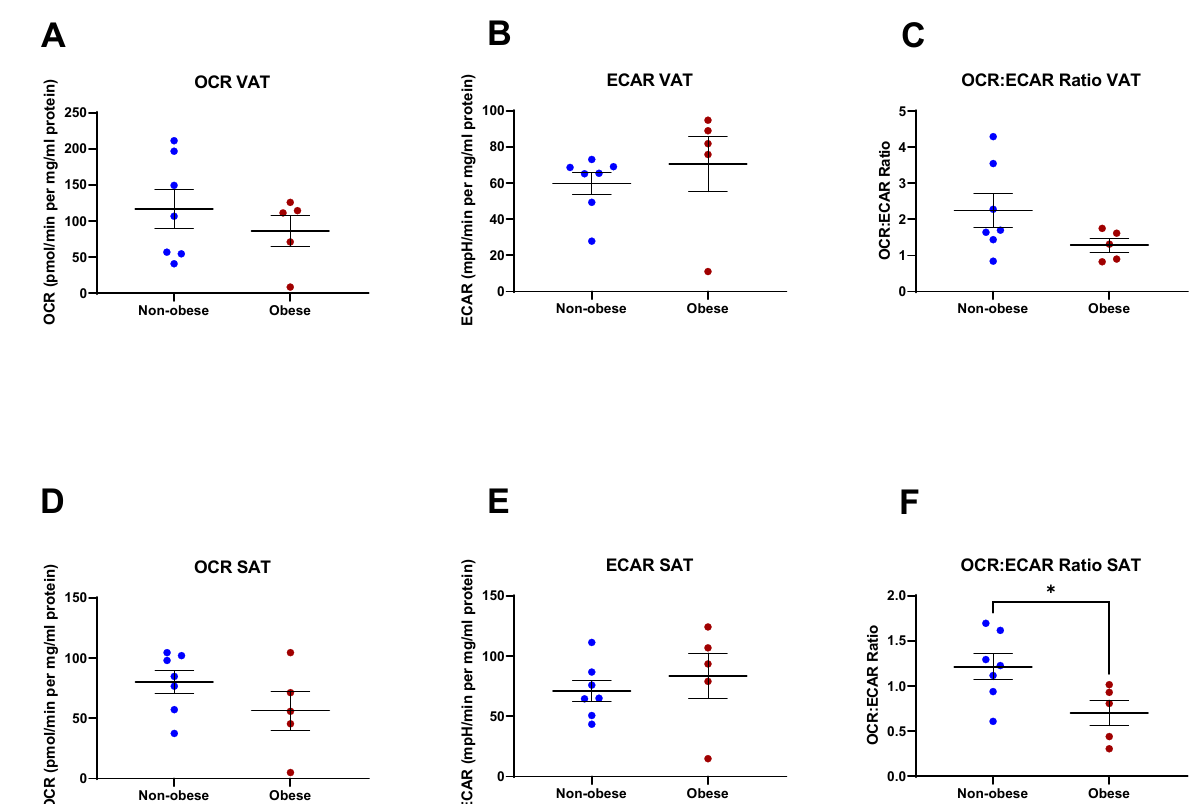
Figure 2. Metabolic analysis of visceral adipose tissue (VAT) and subcutaneous adipose tissue (SAT) by obesity status. There was no significant difference in ( A ) oxygen consumption rate (OCR), ( B ) extracellular acidification rate (ECAR), and ( C ) OCR:ECAR ratio in VAT between non-obese and obese oesophageal adenocarcinoma (OAC) patients. There was no significant difference in ( D ) OCR or ( E ) ECAR in SAT between non-obese and obese OAC patients. ( F ) OCR:ECAR ratio was significantly reduced in SAT of obese compared to non-obese OAC patients. Statistical analysis was performed using a Mann–Whitney U-test. All data expressed as mean ± SEM. n = 7 for non-obese, n = 5 for obese. * p < 0.05.